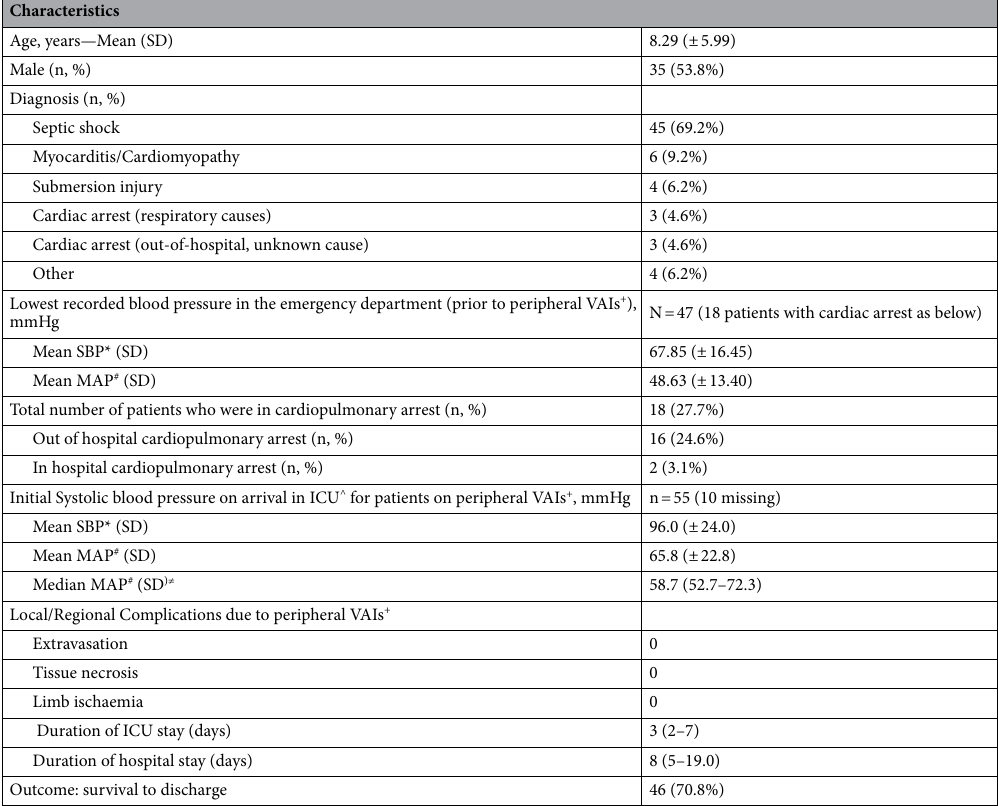
Table 1. Epidemiology and clinical outcomes of paediatric patients who received peripheral vasoactive infusions in the PED. + VAIs (Vasoactive infusions), * SBP (Systolic blood pressure), # MAP (Mean arterial pressure). ^ ICU (Intensive care unit), ≠ Median reported as not meeting test of skew/